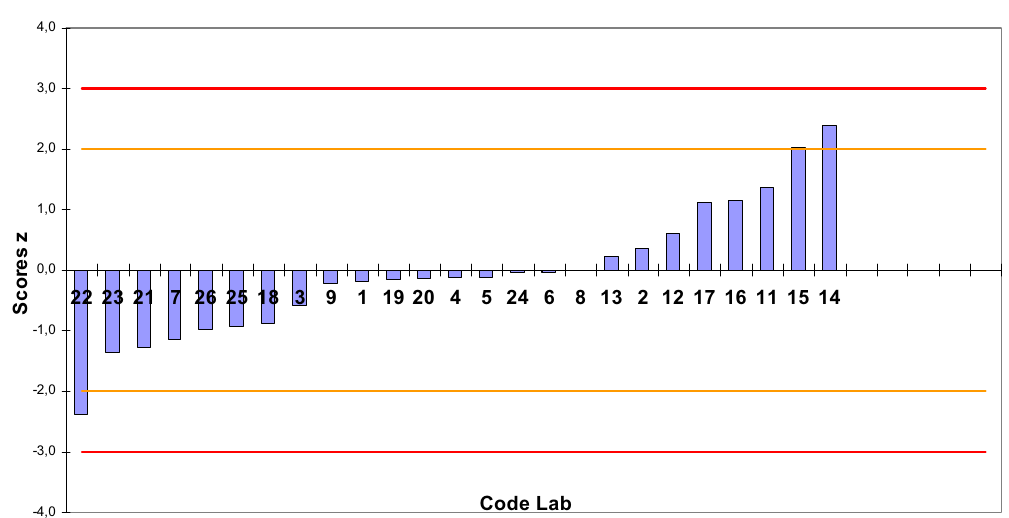
Fig. 3. (Color online) Z -score obtained by the laboratories for the histamine amount in the level 1 PTS sample.